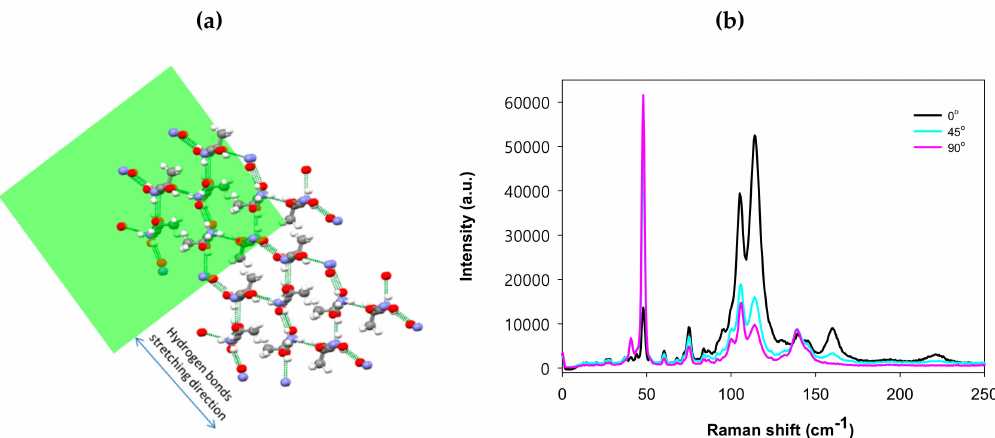
Figure 2. ( a ) Hydrogen bonds’ simulation (dotted lines) in the L-alanine single crystal relative to the (101) plane. ( b ) Low frequency Raman spectra of the crystal excited from the (101) plane in three beam polarization directions: zero (black), 45 (cyan), and 90 (pink) degrees.